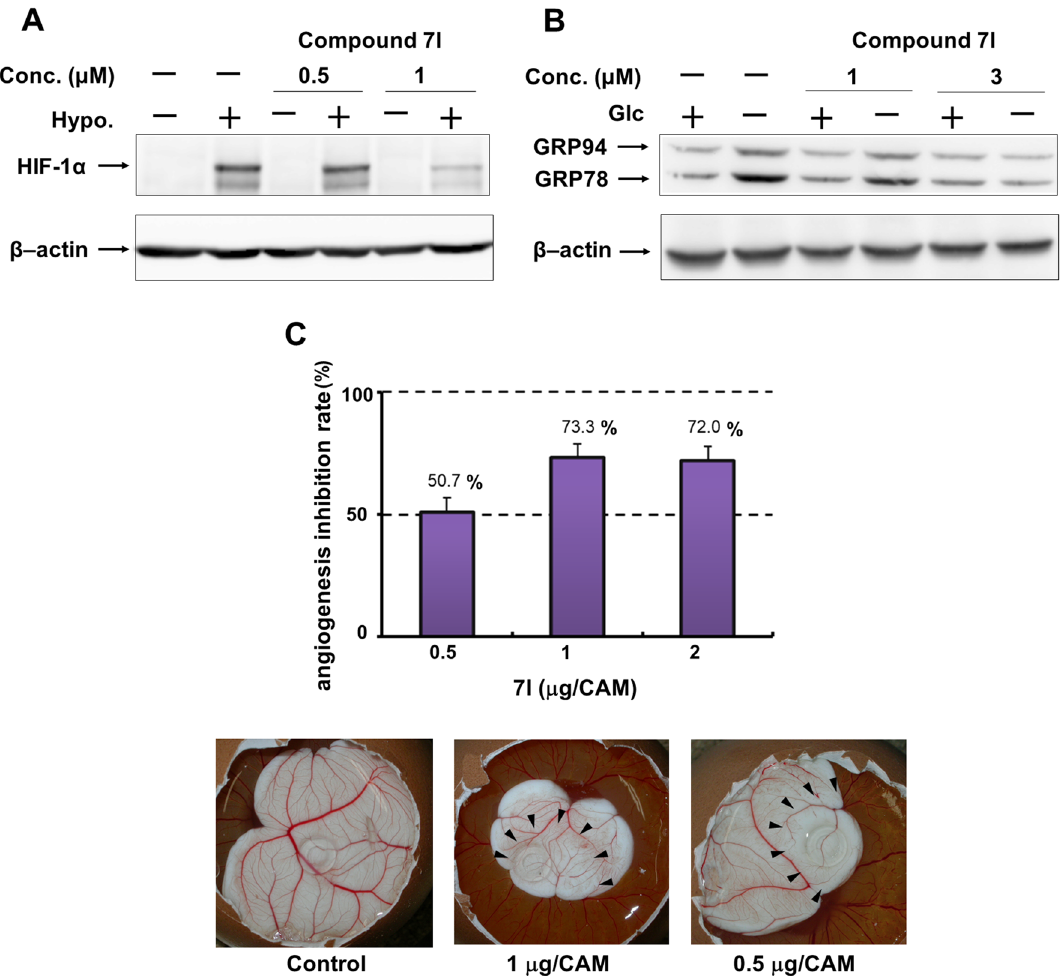
Figure 4. Inhibition effect of 7l on protein expressions of HIF-1α induced under hypoxia or GRP78 and GRP94 by glucose deprivation. Immunoblot analysis of HIF-1α ( A ), GRP78 and GRP94 ( B ) (See also Fig. S7). ( A ) HT29 cells were incubated with compound 7l for 4 h under normoxic (20% O 2 ) (Hypo. −) or hypoxic (1% O 2 ) (Hypo. +) conditions. ( B ) HT29 cells were treated with compound 7l for 24 h in normal (2000 mg/L glucose, Glc +) or glucose-free (Glc −) medium. ( C ) Antiangiogenic effects of compound 7l in CAM assay. The CAMs of 4-day-old chick embryos were treated with compounds for 2 days. Antiangiogenesis ratios of 7l , calculated from the following formula: Antiangiogenesis ratio (%) = (1 − [control point/drug point]) × 100. Eight to ten eggs were used in total for each condition. Pictures of 7l –treated CAM show avascular zone around the silicon ring where the test compound was administered. The area surrounded by arrowheads indicates the hypovascular